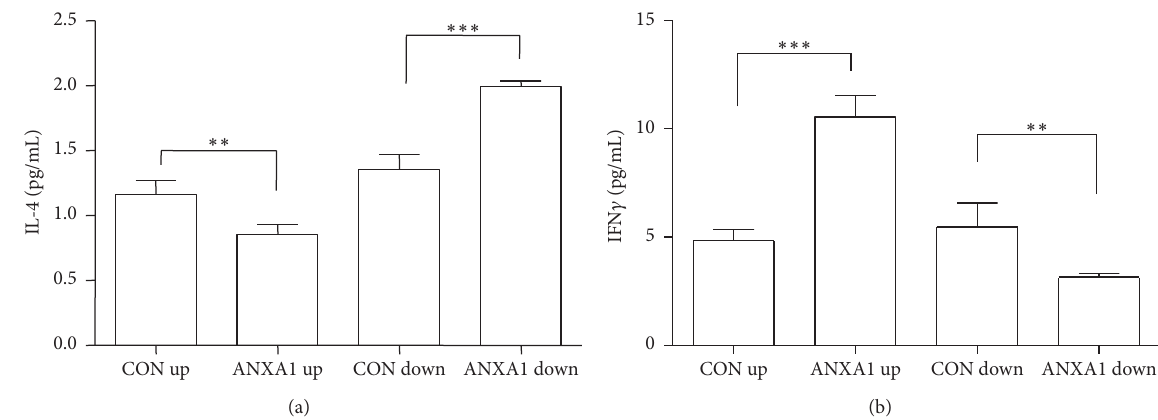
Figure 2: ANXA1 modulates the differentiation of CD4 + T cells in Th0 conditions. CD4 + T cells were infected with ANXA1 up or ANXA1 down Lentivirus in Th0 condition and restimulated with PMA 10ng/mL and ionomycin 1 𝜇 g/mL for 4h. Then Th1 (IFN 𝛾 ) or Th2 cytokine (IL-4) production was to be measured. Values are mean ± SEM of 𝑛 = 3 . ∗∗ 𝑝 < 0.01 . ∗∗∗ 𝑝 < 0.001